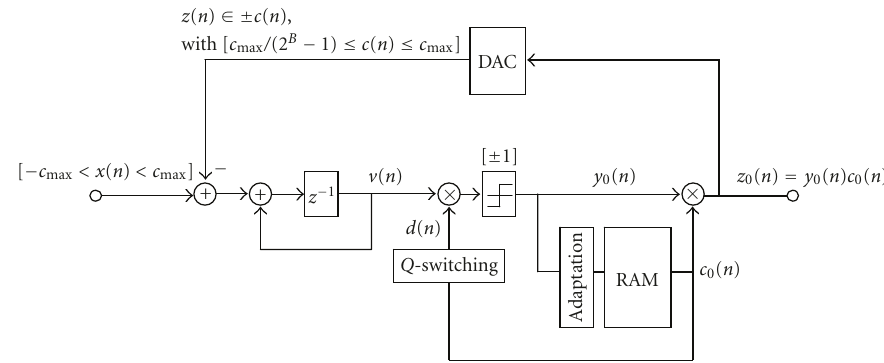
Figure 2: Adaptive ΔΣ M of first